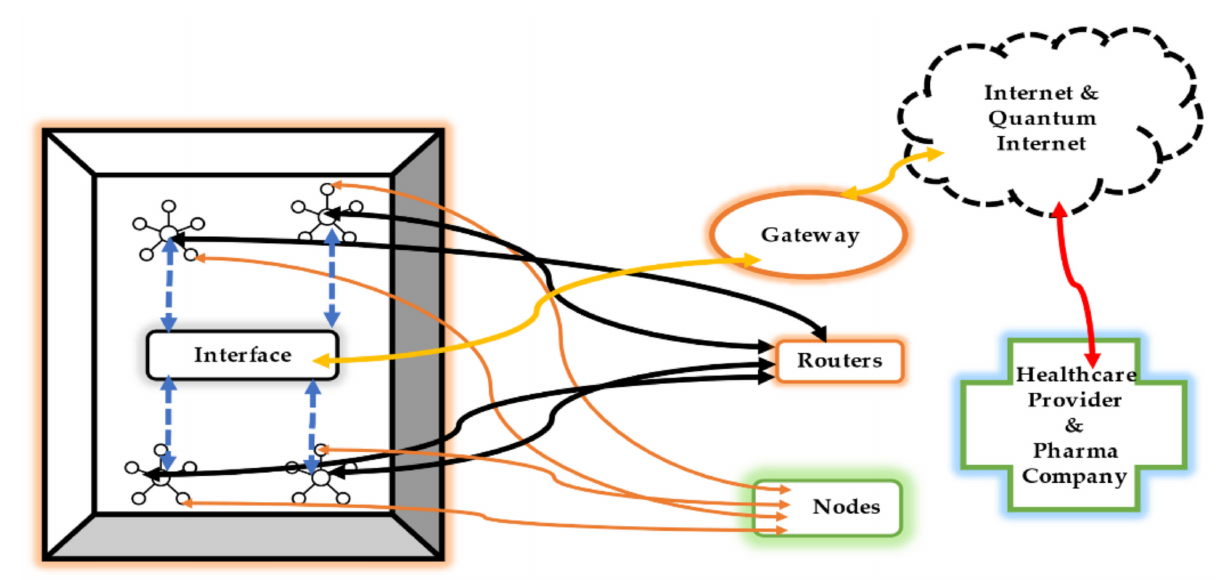
Figure 7. A basic IoVT architecture.